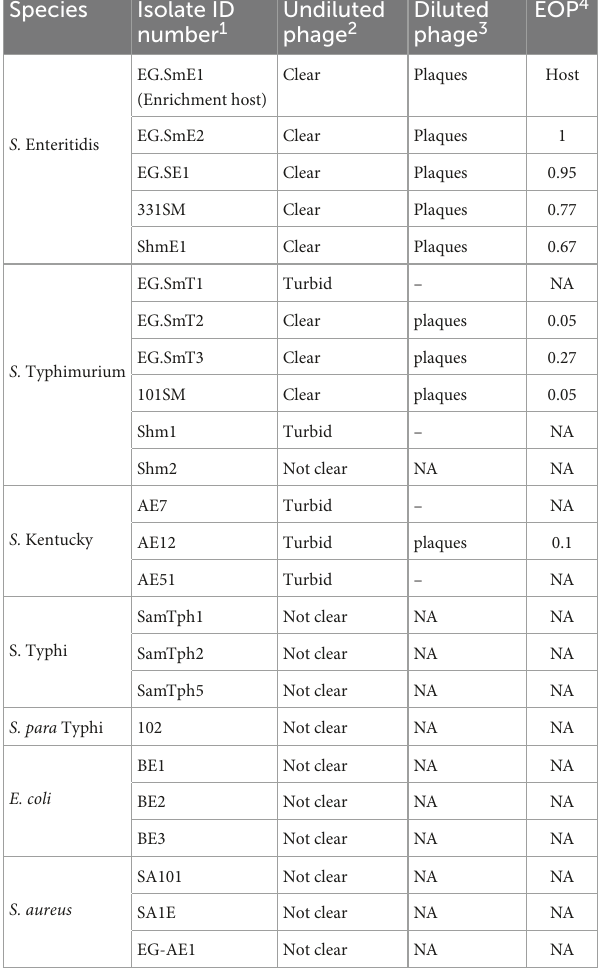
TABLE 2 The host range of phage LPSent1 against different